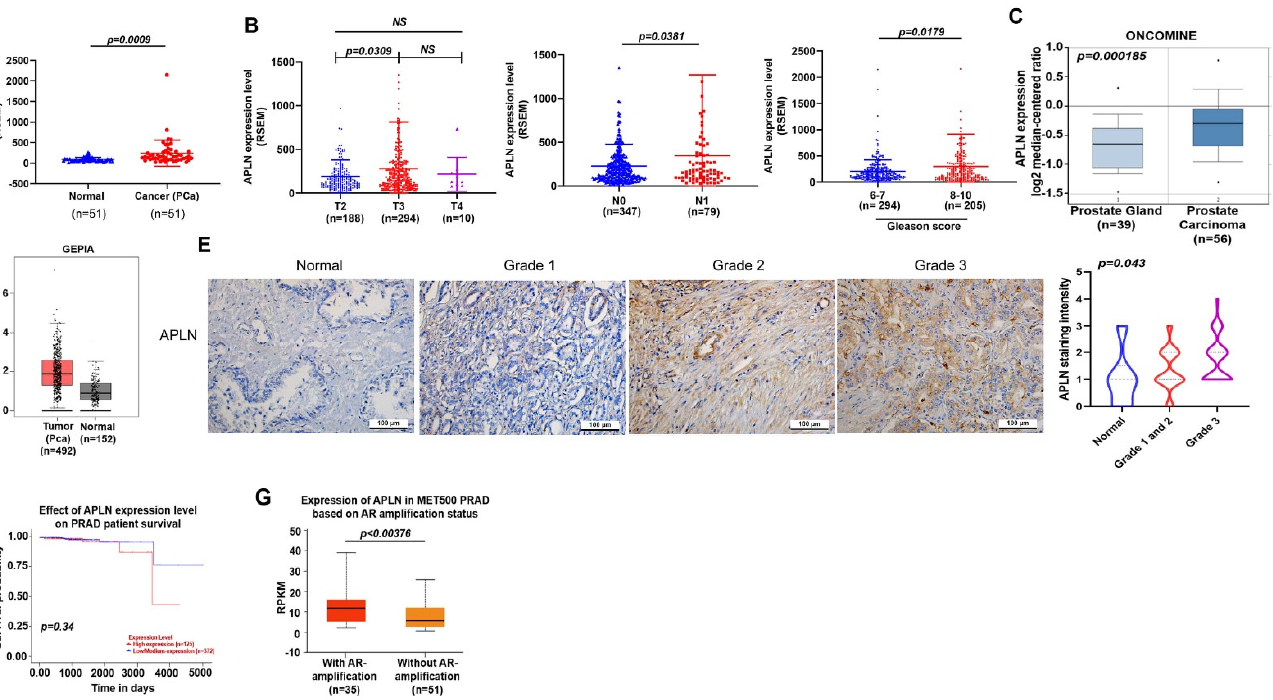
Figure 1. Apelin levels are associated with clinicopathological characteristics in prostate cancer me- tastasis. ( A , B ) Apelin mRNA levels in prostate cancer tissues were examined by the TCGA for tumor volume, lymph node metastasis and Gleason scores. Dots of bar graph means the number of patient. ( C ) Apelin levels in the prostate gland and cancerous prostate tissue from the Oncomine database. ( D ) Apelin expression in prostate cancer tissue samples and normal healthy tissue from the GEPIA database. ( E ) Representative images of IHC staining for apelin in tissue samples from healthy indi- viduals and prostate cancer patients. ( F ) Increasingly lower survival time was associated with in- creasing levels of apelin expression. ( G ) Metastatic prostate cancer exhibited higher levels of apelin expression compared to primary prostate cancer (exposed by AR amplification). Scale bar for all images is 100 μ m. NS, no significant difference.